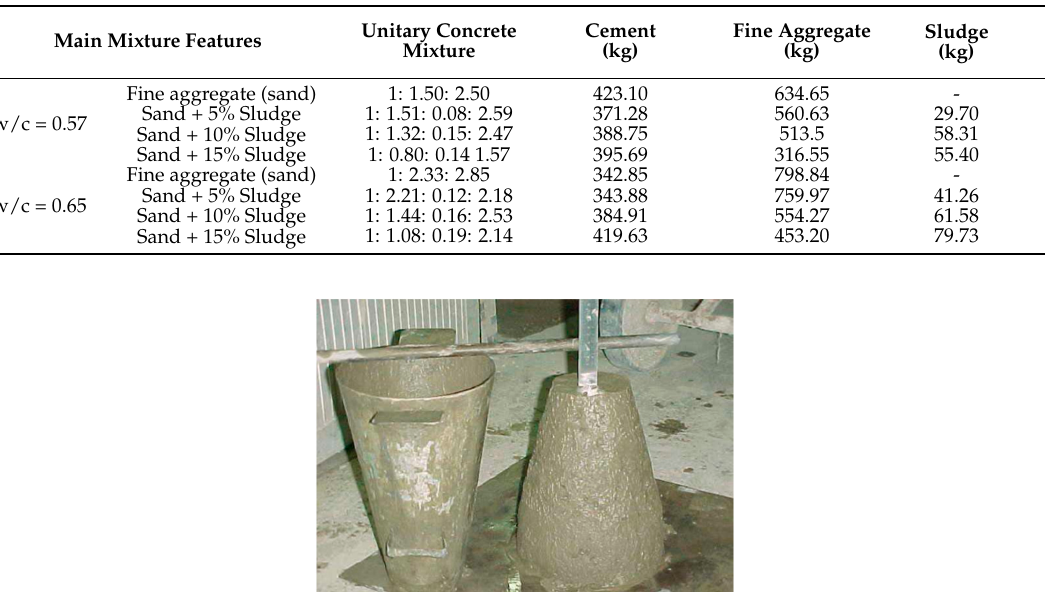
Table 2. Concrete mixtures and material consumption per m 3 ( w / c = 0.57 and w / c = 0.65).